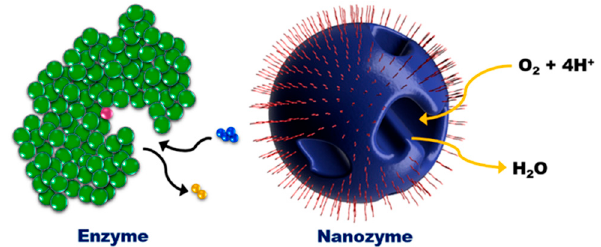
Figure 3. Illustration of a nanozyme as a 3D geometric architectural mimic of an enzyme. (Re- printed with permission from [63]. Copyright © 2018, American Chemical Society).